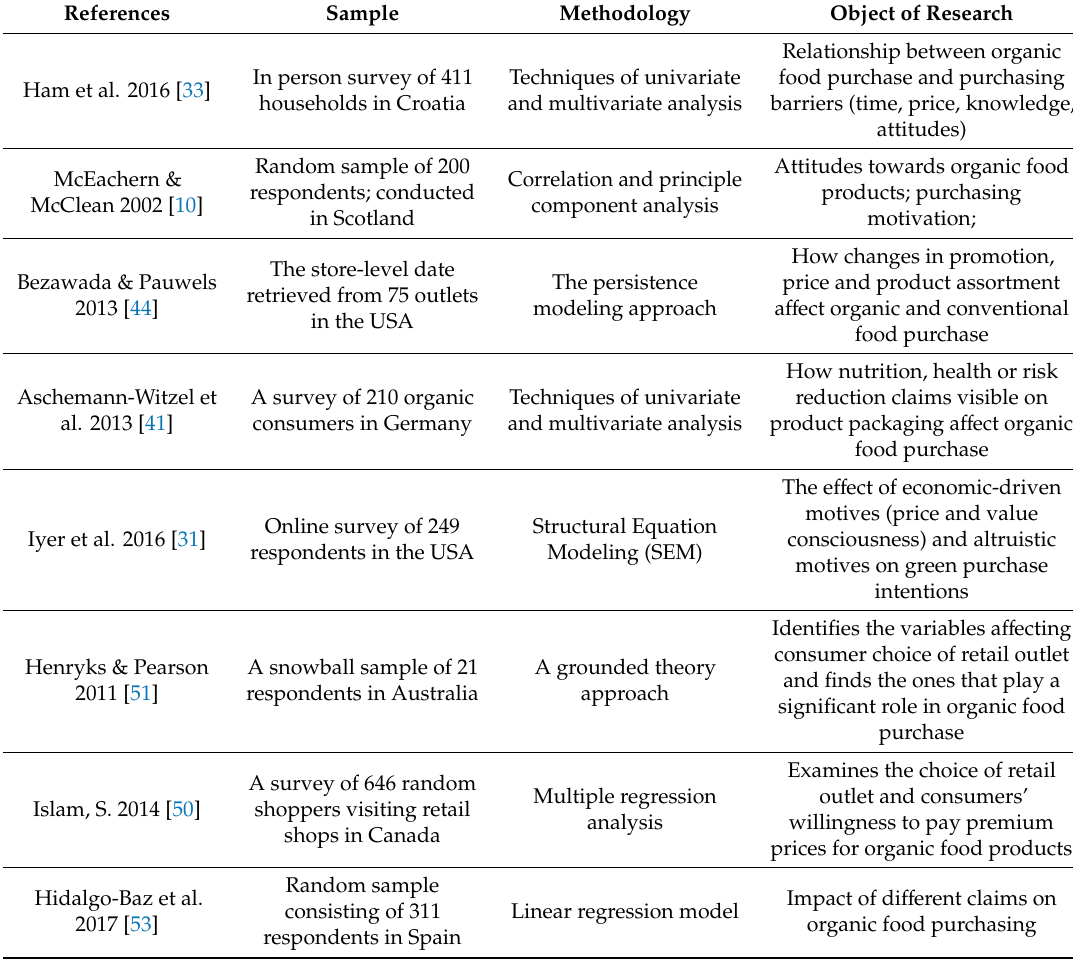
Table A1. Previous research undergrounding the conceptual model of